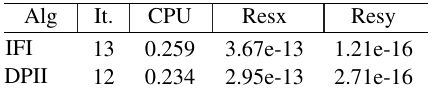
Table 3. Numerical results for Example 3